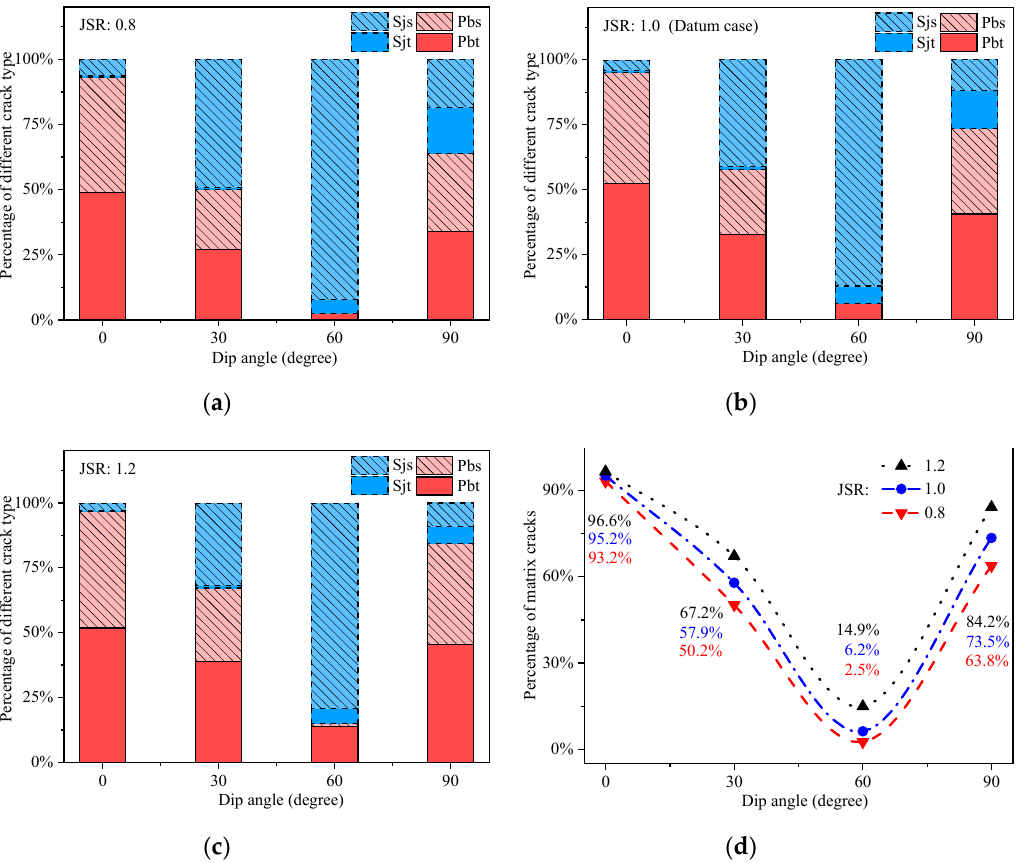
Figure 9. Effects of the JSR on the crack types in uniaxial compression (Sjs denotes shear crack of beddings; Sjt denotes tensile crack of beddings; Pbs denotes shear crack of matrix; Pbt denotes tensile crack of matrix). ( a ) JSR = 0.8; ( b ) JSR = 1.0; ( c ) JSR = 1.2; ( d ) comprehensive comparison of matrix cracks